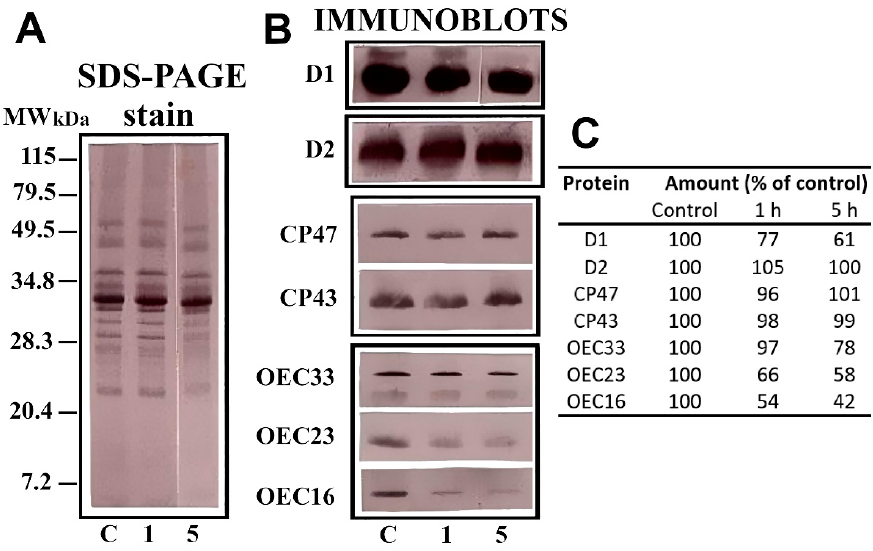
Figure 4. ( A ) Sodium dodecyl sulphate polyacrylamide gel electrophoresis (SDS-PAGE)